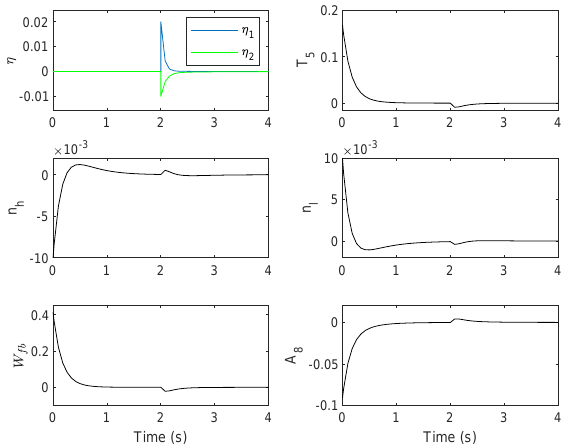
Figure 19. Intelligent SMFTC for aircraft engine with lumped disturbance since 2nd